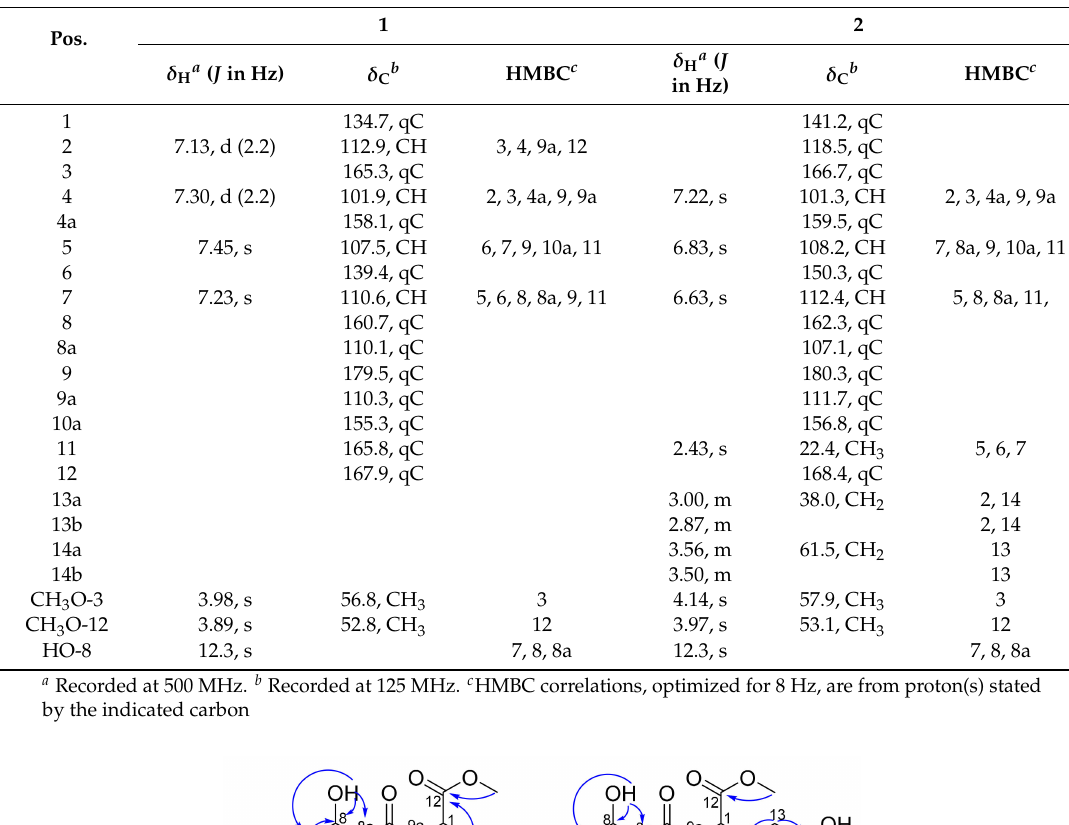
Table 1. NMR data for compounds 1 (DMSO- d 6 ) and 2 (acetone- d 6 ).